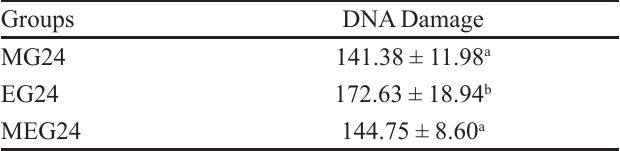
MG24 – 24-hour methionine group; EG24 – 24-hour ethanol group; MEG24 – 24-hour methionine plus ethanol group; Means followed by different letters differed significantly